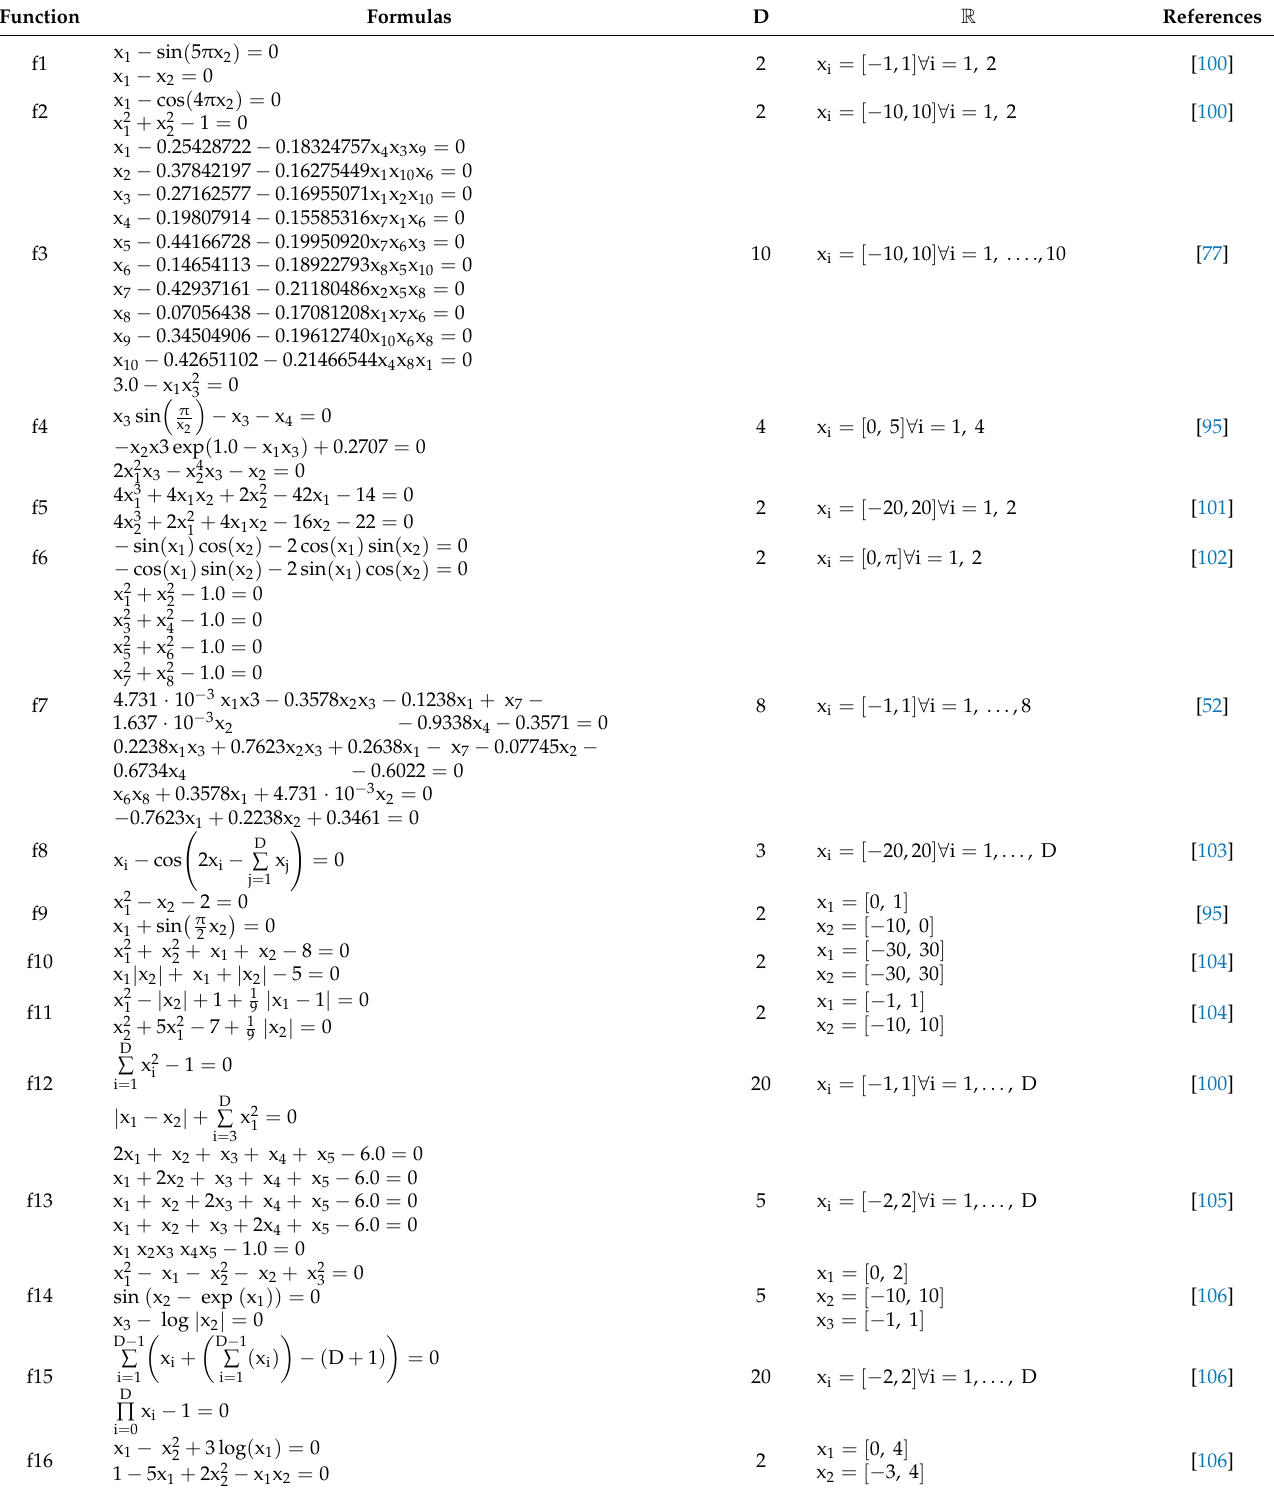
Table 2. The descriptions of used